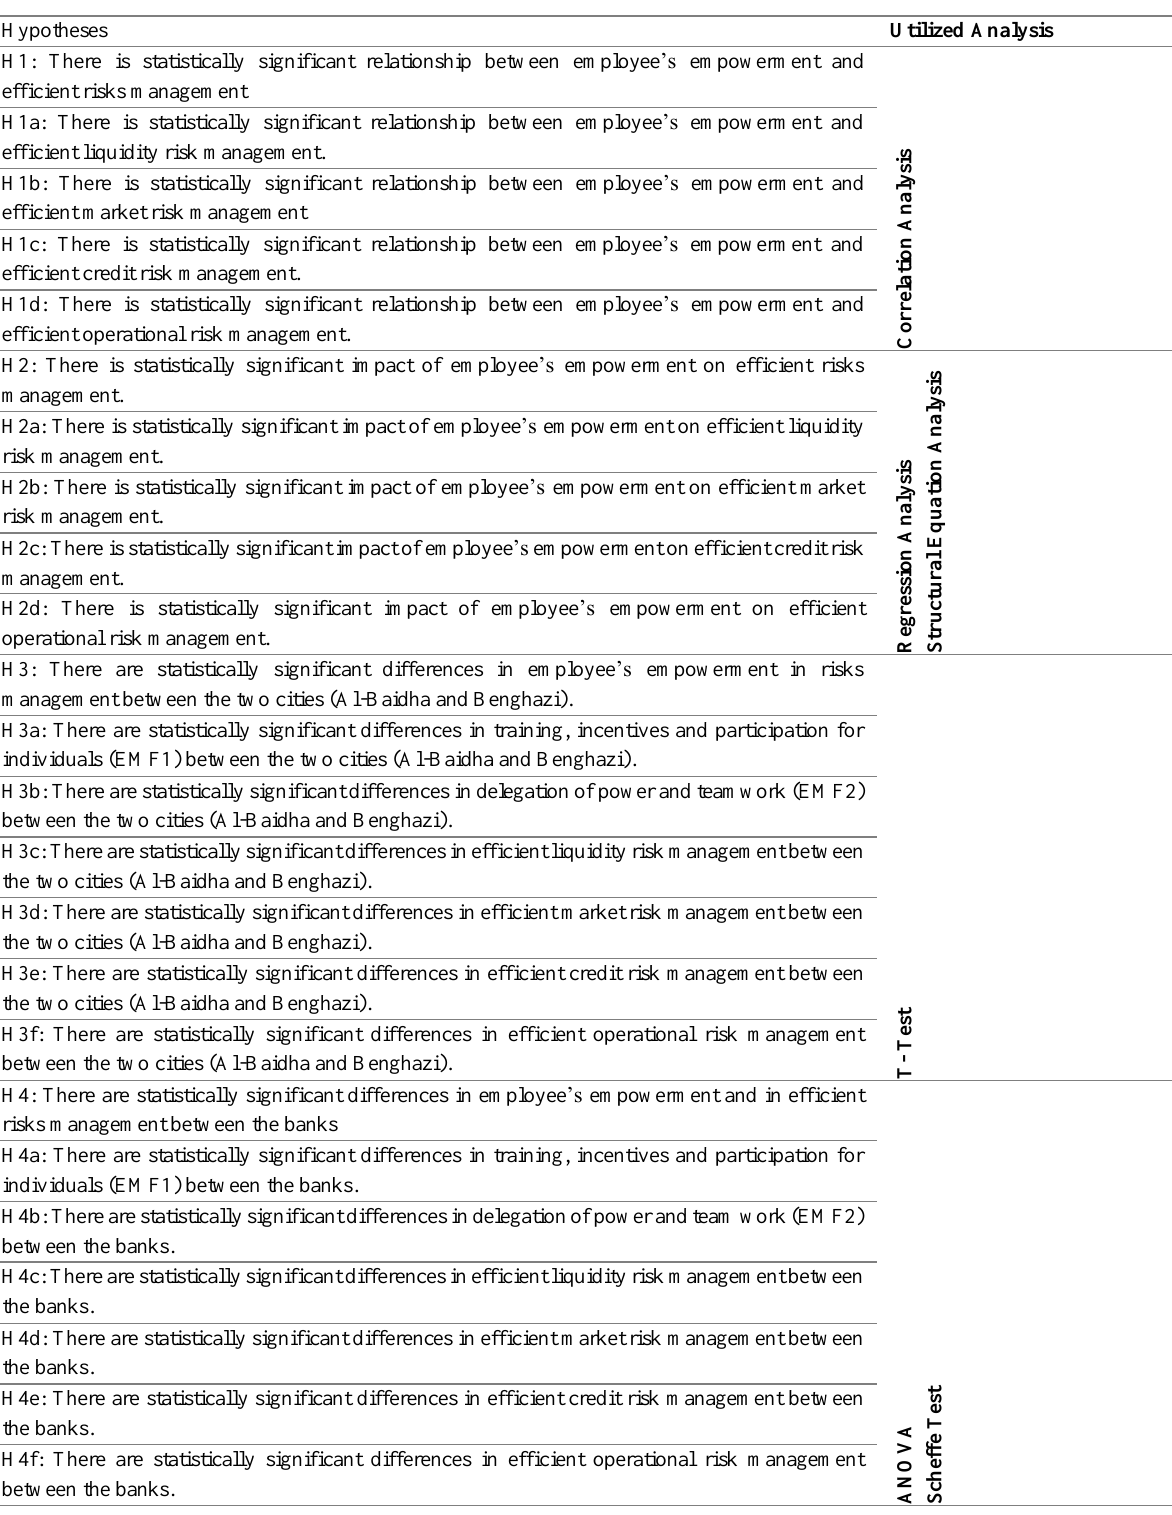
Table 4: Hypotheses of the study Hypotheses Utilized